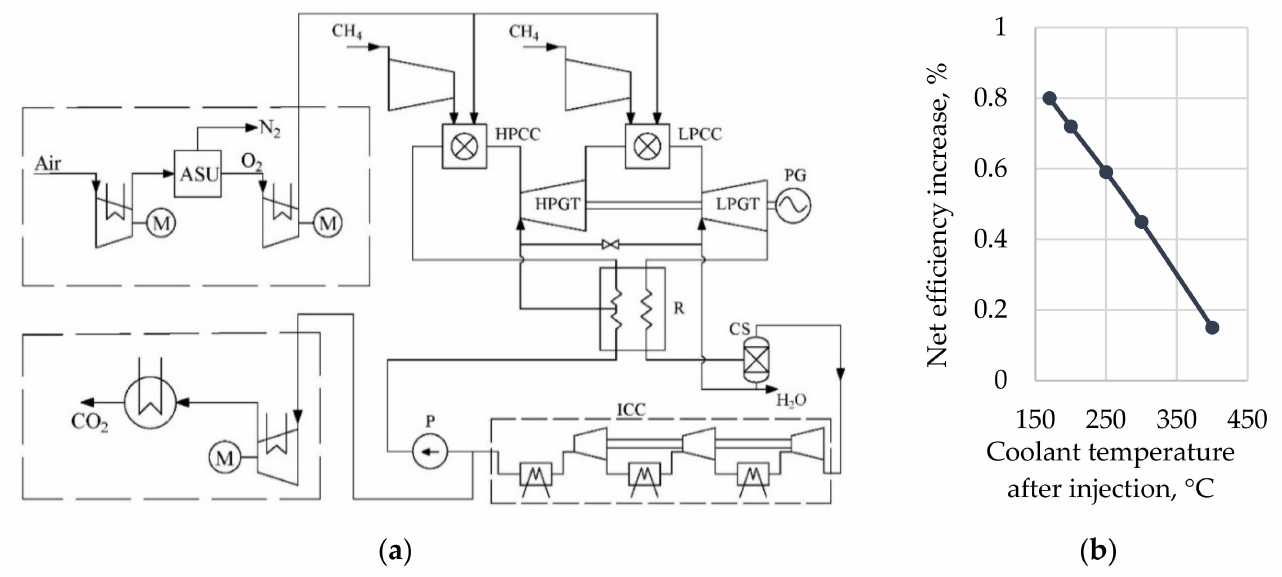
Figure 12. The E-MATIANT cycle with the cooling flow precooling: ( a ) heat flow chart; ( b ) coolant temperature after the injection influence on the cycle net